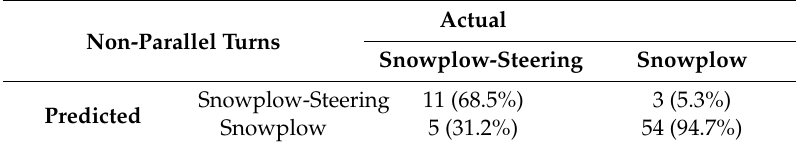
Table 10. Confusion matrix for non-parallel turns—Random forest.